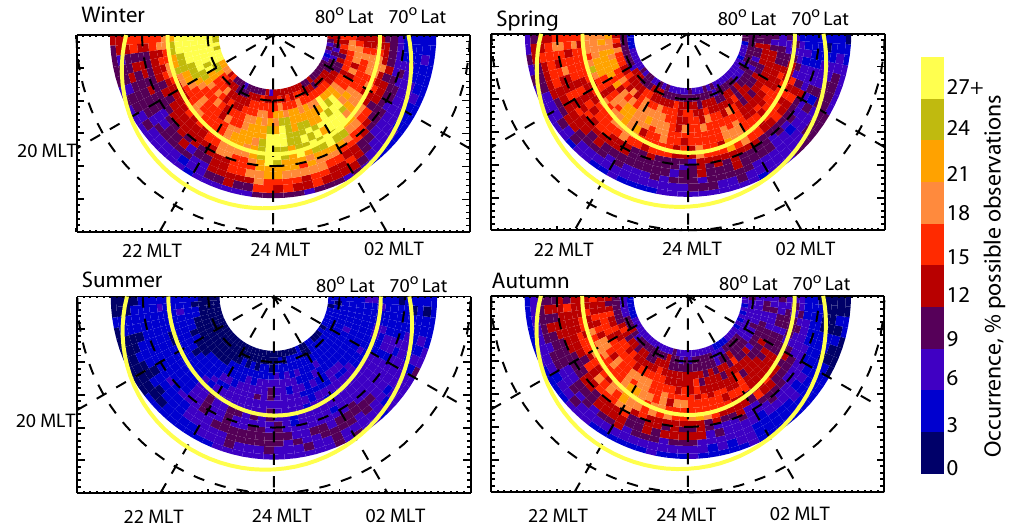
Fig. 2. Colour-coded plots of the data occurrence observed by the Iceland East radar as a function of Northern Hemisphere season, MLT and latitude for the three years of data. Each square of colour represents an interval of 15min of MLT and one statistical summary point. The colour scale indicates the number of observations of ionospheric scatter above 3 dB as a percentage of the total possible observations in that season from the database used. A statistical auroral oval for a K p of 2 is overlaid for